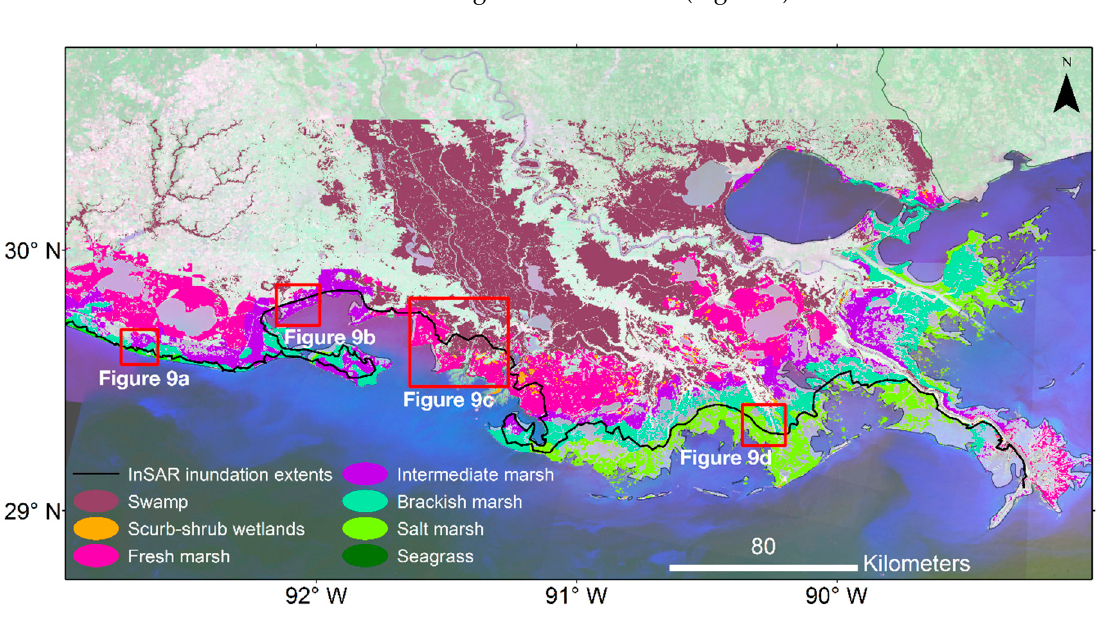
Figure 8. Wetland classification map from Gulf-Wide Information System (G-WIS) [19] and InSAR detected tidal inundation extents through Louisiana coastal wetlands (black line). The red frames show the location of detailed observations presented in Figure 9.